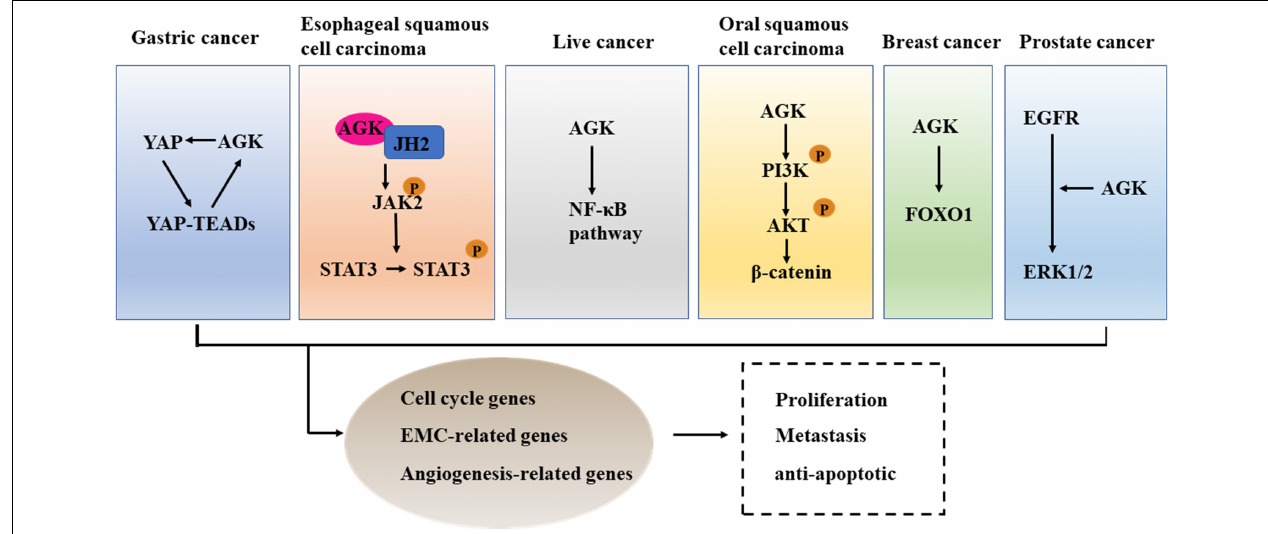
FIGURE 7 | The cross talk between AGK and cancer-related pathways. AGK is participating in the differentiation, metastasis, and anti-apoptosis of tumor cells by adjusting Hippo-YAP1, JAK2/STAT3, NF- κ B, and PI3K/Akt signaling pathways, FOXO1, and EGF transcription factor. YAP1, Yes-associated protein 1; TEAD, transcriptional enhanced associated domain; JH2, Janus kinase homology 2; JAK2, Janus kinase 2; STAT3, signal transducer and activator of transcription 3; NF- κ B, nuclear factor-kappa B; PI3K, phosphatidylinositol 3-kinase; Akt, protein kinase B; FOXO1, forkhead box O1; EGFR, epidermal growth factor receptor; ERK, extracellular regulated protein